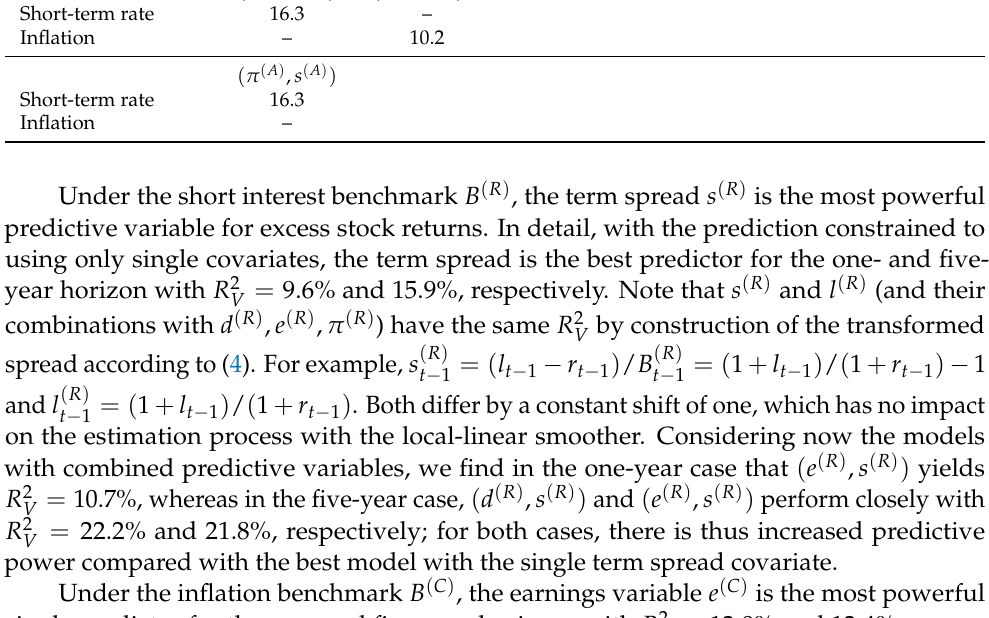
( A ) corresponding to the t